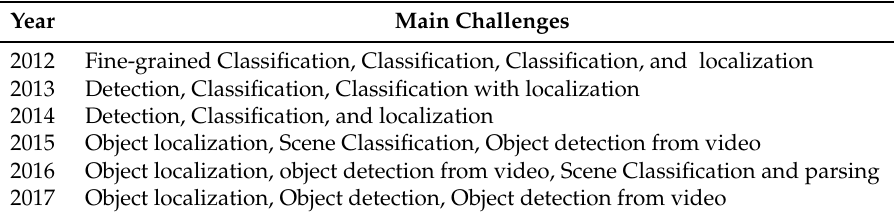
Table 6. ILSVRC image classification dataset statistics.